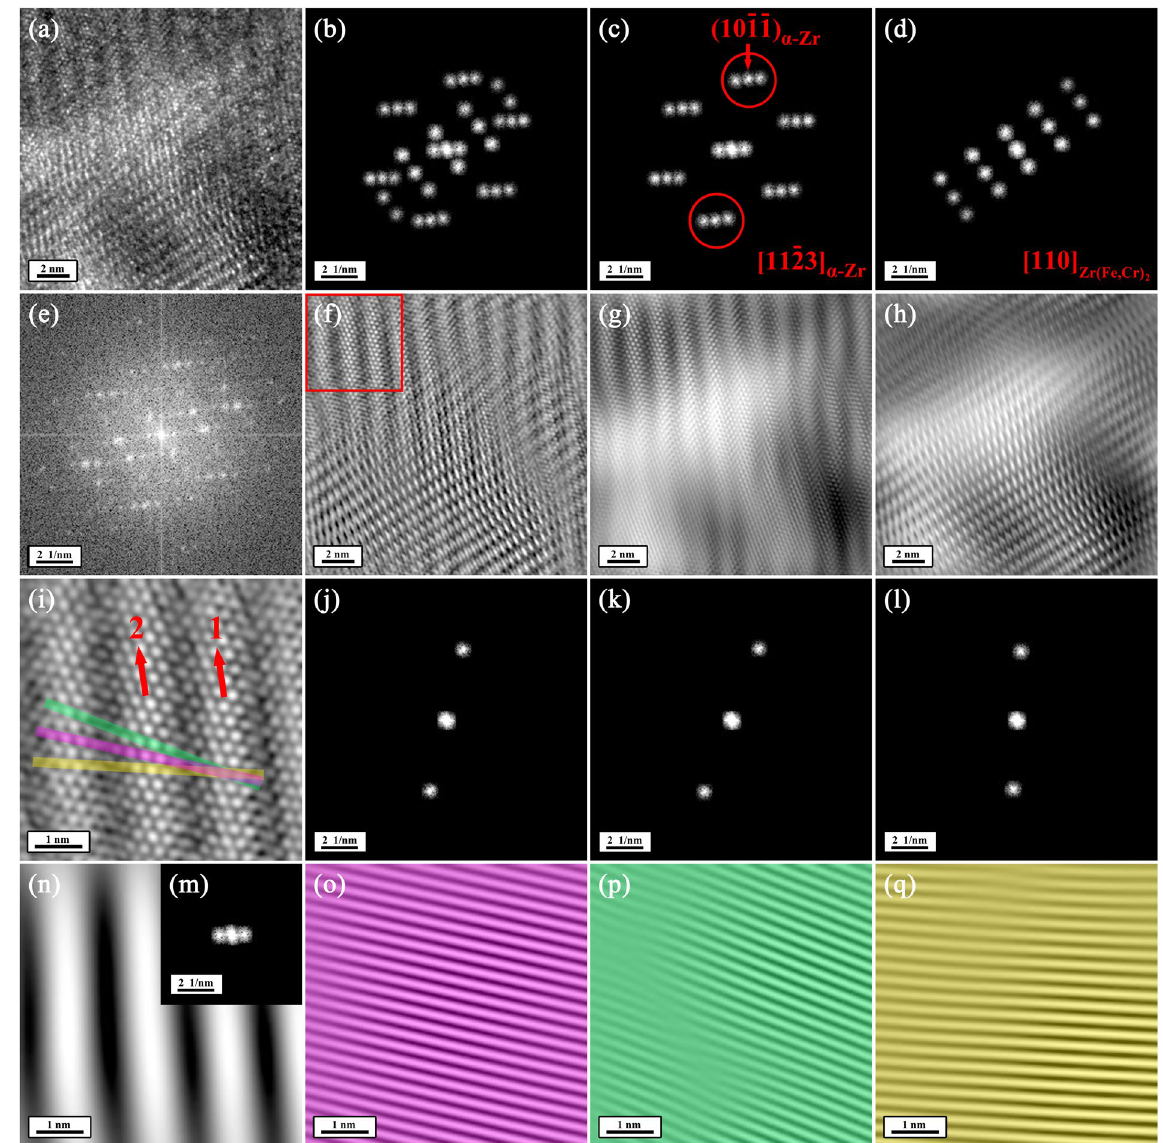
Figure 4. Moiré fringes at the perimeter of the precipitate of interest. ( a ) HRTEM image showing an area where fringes disappeared at the interior of the precipitate viewed along the [11 ̄ 2 3] α -Zr direction. ( e ) The FFT diffraction pattern corresponding to Fig. 4a. ( b , c and d ) The partially masked FFT diffraction patterns corresponding to Fig. 4c. ( f,g and h ) The noise-filtered IFFT images corresponding to Fig. 4a obtained by using the partially masked FFT diffraction patterns in Fig. 4(b,c and d), respectively. In Fig. e, b and c, it can be seen that every FFT diffraction spot (including the central FFT diffraction spot) belonging to α -Zr phase along [11 ̄ 2 3] α -Zr diverges into three spots. ( i ) The expanded morphology of the area outlined by a red square in Fig. 4f. ( j , k and l ) The three diverged FFT diffraction spots corresponding to the (10 ̄ ̄ 11 ) α -Zr planes, respectively. ( o,p and q ) The IFFT images corresponding to Fig. 4i obtained by using the masked FFT diffraction spots in Fig. 4j, k and l, respectively. ( m ) The three diverged spots of the central FFT diffraction spot. ( n ) The IFFT image corresponding to Fig. 4i obtained by using the masked FFT diffraction spots in Fig. 4m. The divergence of the FFT diffraction pattern corresponding to α -Zr phase along [11 ̄ 2 3] α -Zr as well as the central FFT diffraction spot is due to the presence of the fringes. Take the (10 ̄ ̄ 11 ) α -Zr planes for example. The (10 ̄ ̄ 11 ) α -Zr planes on fringes (pink bar in Fig. 4i) can still form periodic planes (Fig. 4o). The (10 ̄ ̄ 11 ) α -Zr planes on Fringe 1 in Fig. 4i can line up with their two adjacent (10 ̄ ̄ 11 ) α -Zr planes on Fringe 2 in Fig. 4i (green and yellow bars in Fig. 4i) and form periodic planes (Fig. 4p and q), respectively. In addition, the fringes themselves are periodic, resulting in the divergence of the central FFT diffraction spot as seen in Fig. 4n and